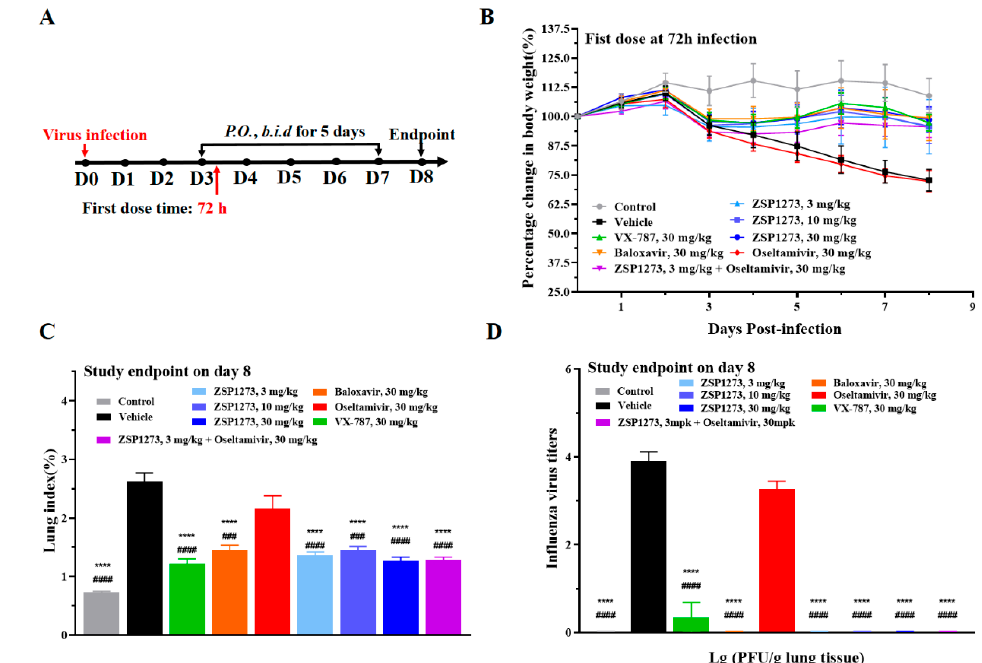
Figure 8. The antiviral activity of ZSP1273 in murine infection experiment V (n = 10, mean ± SEM): ( A ) Flowchart of the experiments: the day of H1N1 infection is defined as day 0, the first day after infection is denoted as day 1, and so forth. ( B ) Changes in the weight of mice in each group after infection. ( C ) Lung index—which is a ratio of the lung weight to body weight—on day 8 in each group. ( D ) Influenza A viral titers on day 8. Error bars represent the standard error of the mean value. Note: **** p < 0.0001 (vs. vehicle); ### p < 0.001, #### p < 0.0001 (vs. oseltamivir).